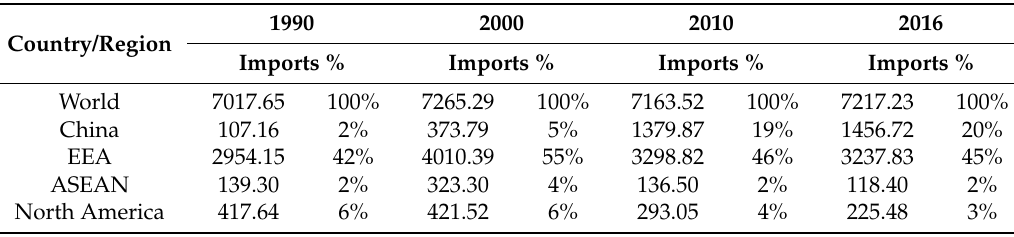
Table 1. The amount and percentage of the UK textile raw materials imports from China and three free trade regions (unit: USD in